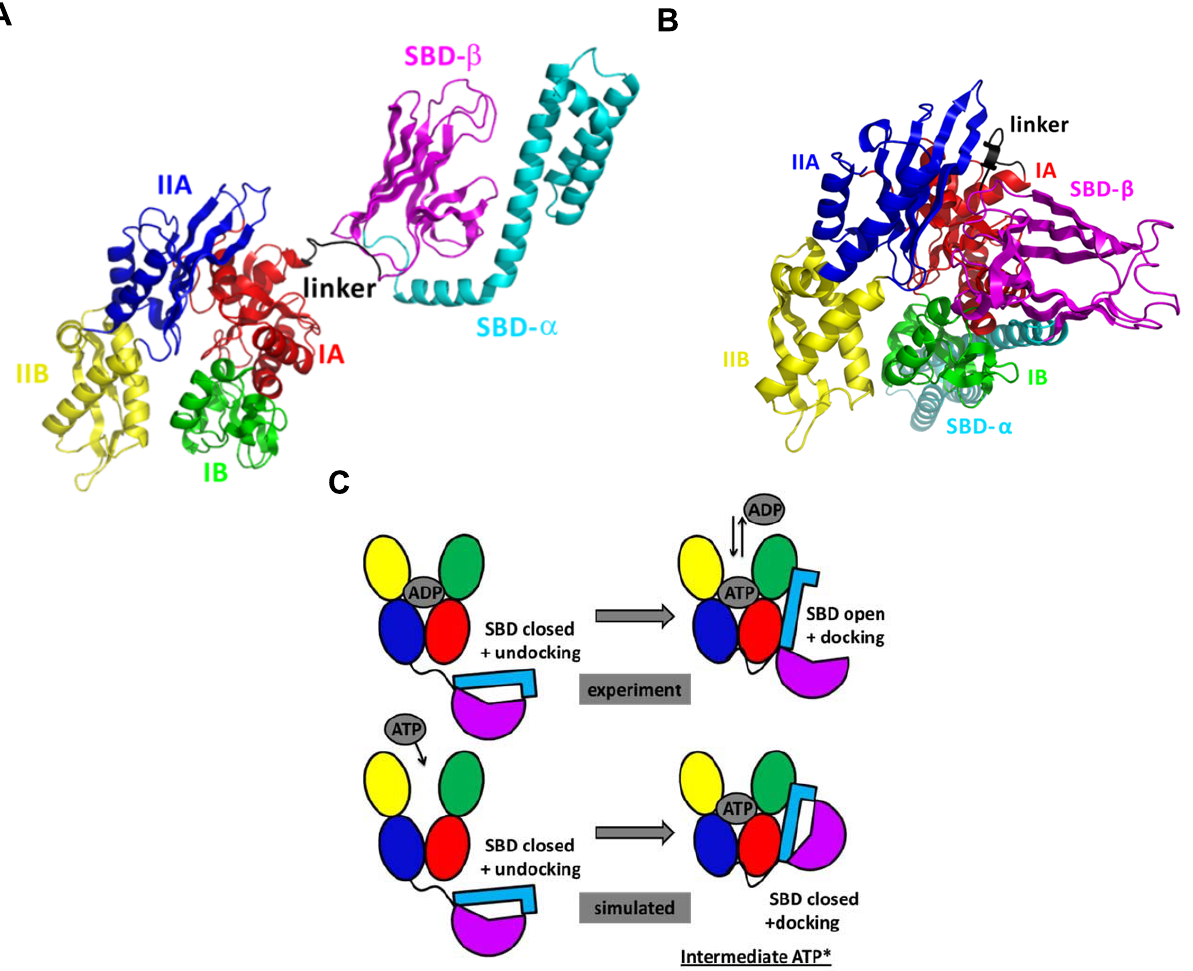
Figure 1. Nucleotide-dependent conformational states of Hsp70 s. A: Cartoon diagram of the experimental NMR structure of E. coli ADP-Hsp70 (PDB ID: 2KHO) [70] used as input structure for the MD simulations. B: Cartoon diagram of the experimental X-ray structure of E. coli ATP-Hsp70 (PDB ID: 4B9Q) [69]. C: Schematic representation of the conformational transition as expected from experimental data and observed in MD simulations of ATP- Hsp70, starting from the closed conformation of Hsp70. The color code is the following: NBD-IA (residues 4–37, 112–182 and 363–383; red), NBD-IB (residues 38–111; green), NBD-IIA (residues 183–227 and 311–362; blue), NBD-IIB (residues 228–310; yellow), linker (residues 384–393; black), SBD- b (residues 394–502; magenta) and SBD- a (residues 503–603; cyan). These figures were prepared with PyMOL